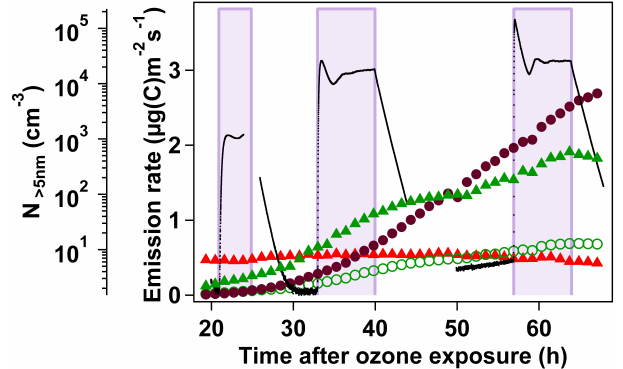
Fig. 1. Temporal evolution of VOC emissions from a wild type Grey poplar plant after chronic ozone exposure. While isoprene (red triangles) is unaffected, the sum of all monoterpenes (MT, green triangles, for clearer visualization MTx100 is displayed), sum of sesquiterpenes (SQT, green circles), and sum of aromatic compounds (brown circles) increase after ozone exposure. Dur- ing episodes of photochemical simulation in the reaction chamber (purple shaded areas) new particle formation is observed with the number concentration (black dotted line) increasing with increasing VOC